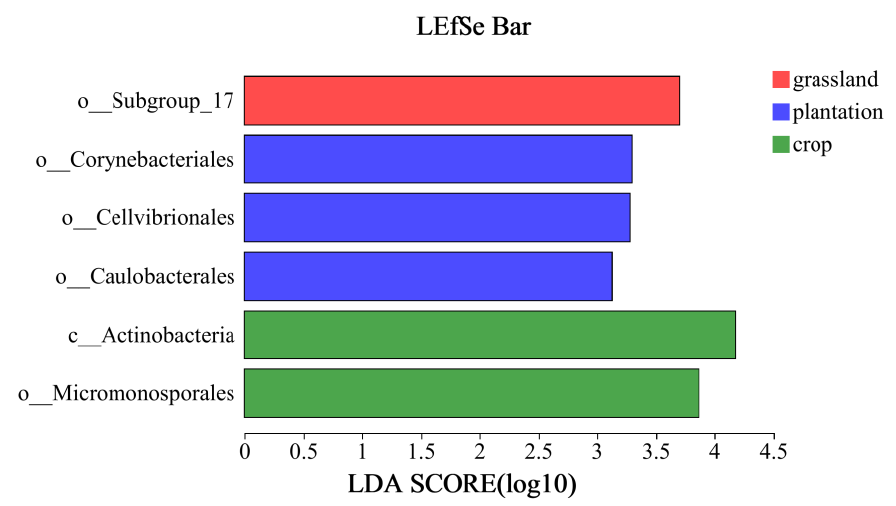
Figure 8. Histogram of LDA value distribution of soil bacterial species in three karst land-use types.